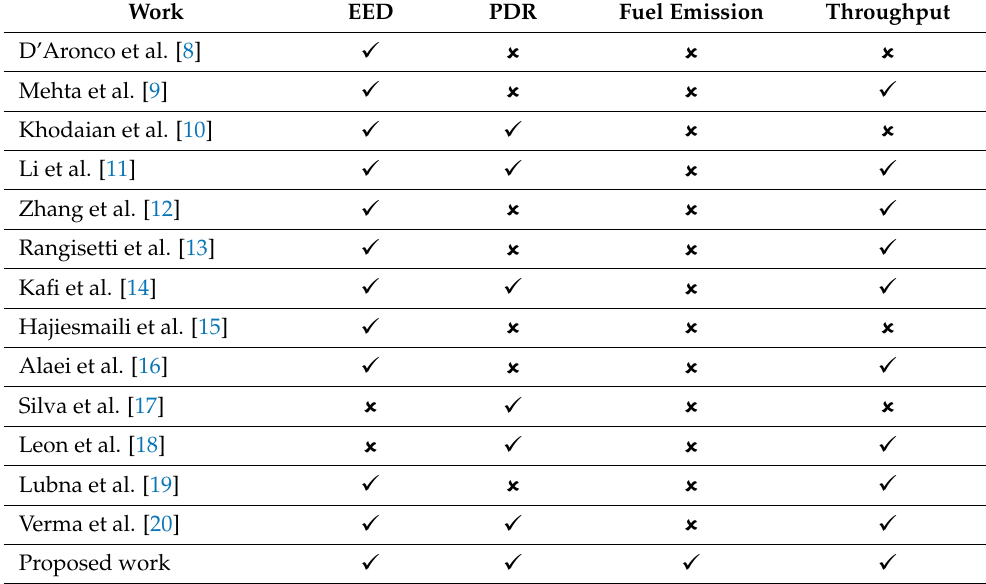
Table 1. Traffic congestion control parameters of FANET.